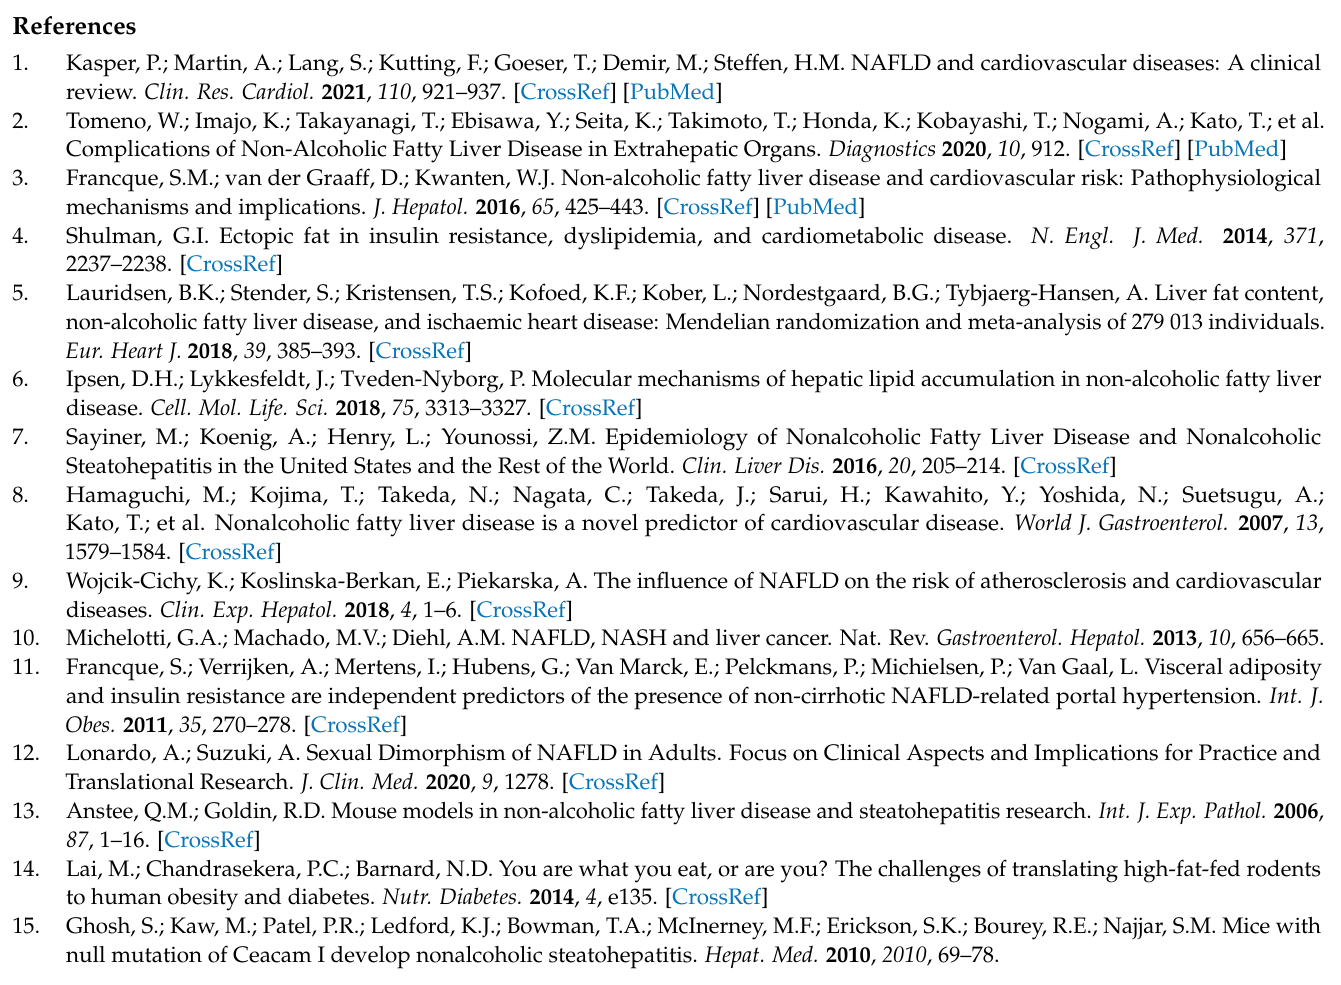
Figure S3: Comparative biodistributions of [ 18 F]FTO in WT vs. Ceacam1 − / −